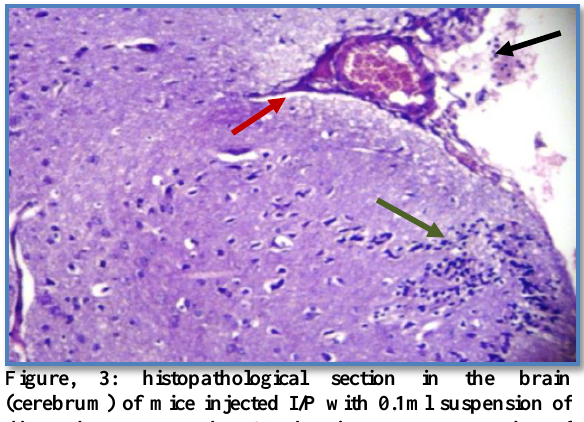
Figure, 3: histopathological section in the brain (cerebrum) of mice injected I/P with 0.1ml suspension of digested organs at day 21 showing sever congestion of meningeal blood vessels ( ) with infiltration of inflammatory cells ( ) and focal aggregation of microglial cells ( ) H and E